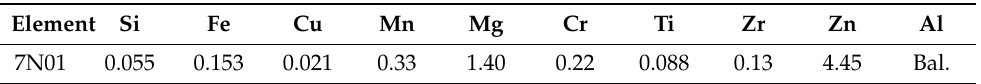
Table 1. Chemical compositions of the 7N01 extrusion aluminum alloy (wt.%).